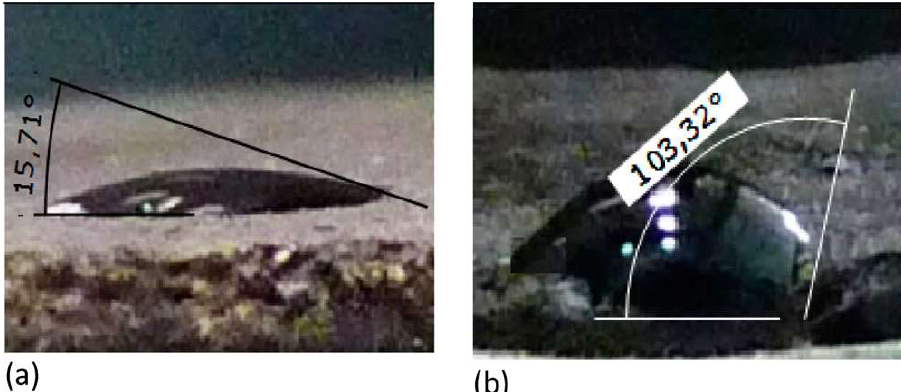
Figure 2. Oil-air contact angle on rock surface before ( a ) and after ( b ) being treated with 100 ppm Al 2 O 3 NPs. Reproduced with permission from reference [124]. Copyright 2013 American Chemical